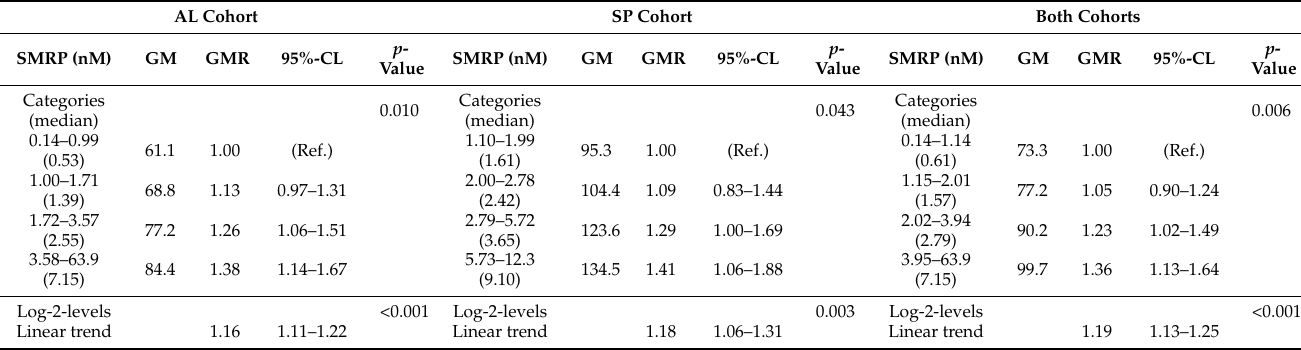
Table 3. Association between SMRP levels and mRECIST score estimated through a log-normal random-effects regression method in MPM